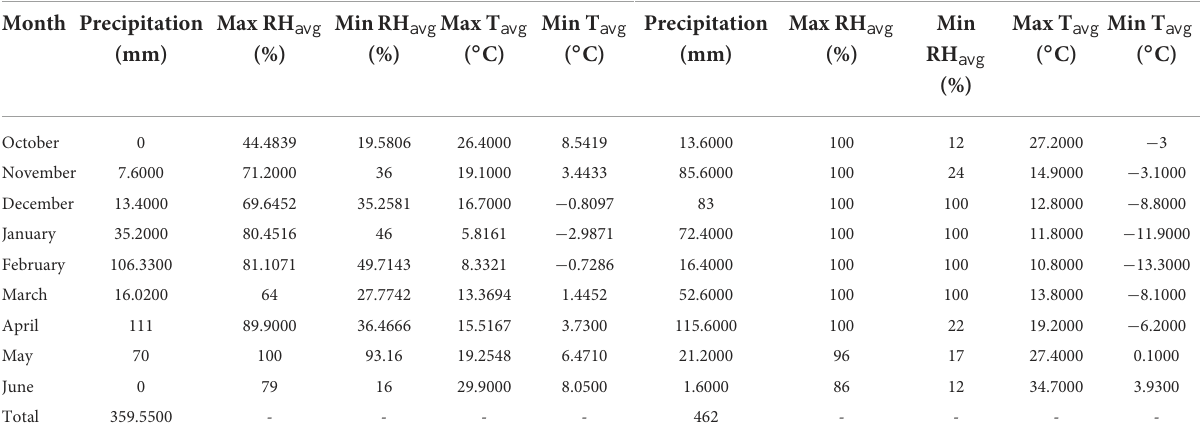
TABLE 2 Monthly precipitation, average maximum and minimum relative humidity (Max RH avg and Min RH avg ), average maximum temperature (Max